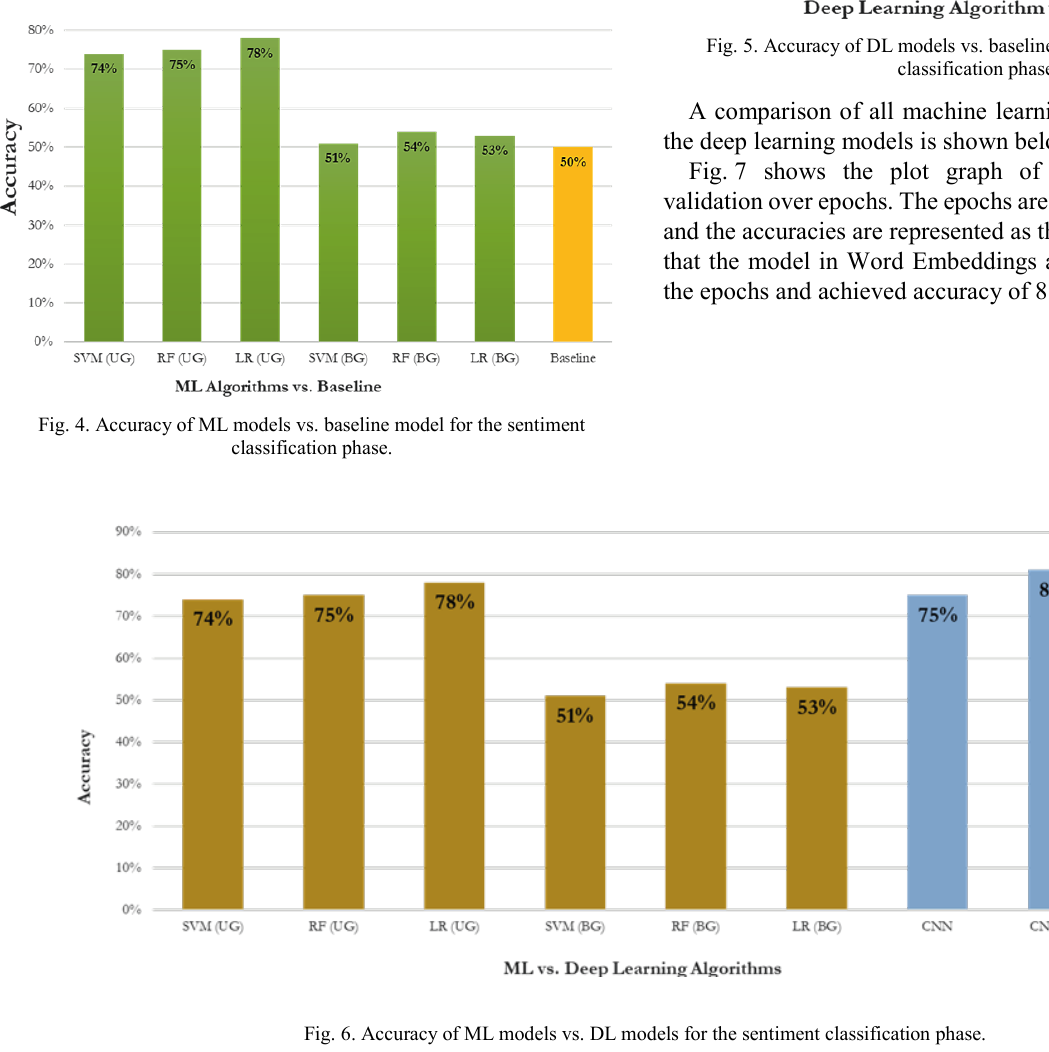
Fig. 6. Accuracy of ML models vs. DL models for the sentiment classification